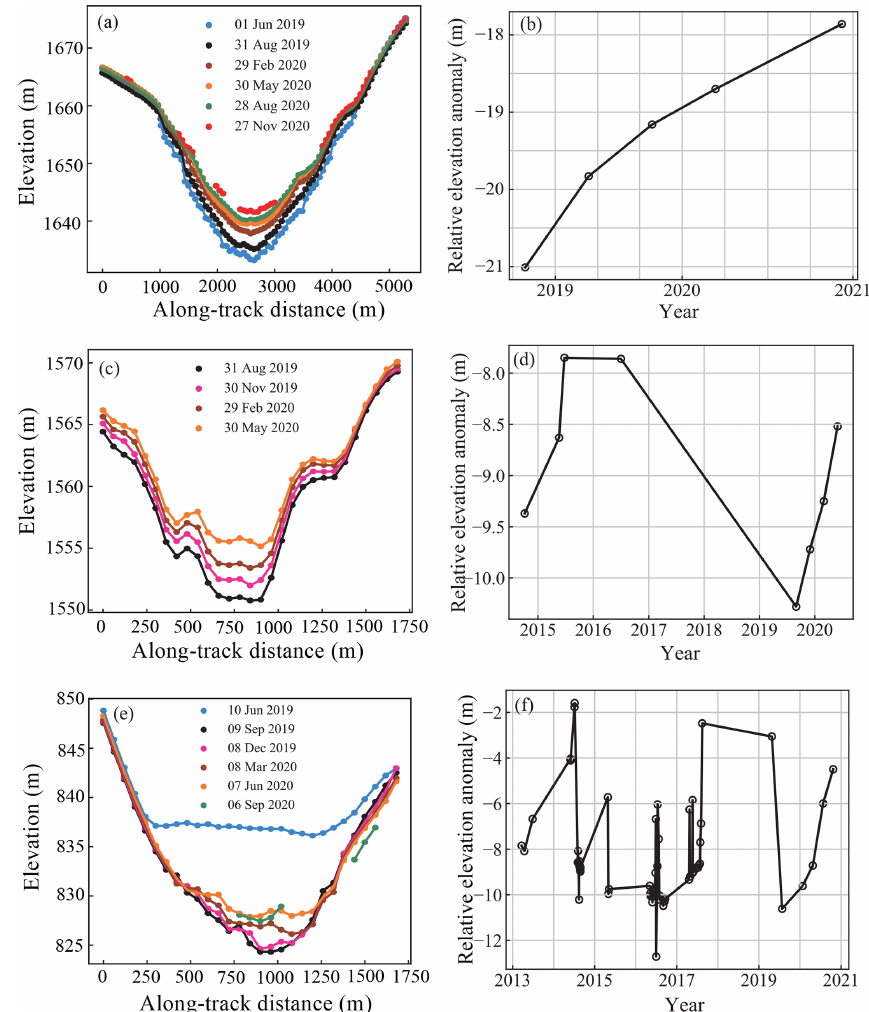
Figure 3. Examples of lake confidence-level classification. Panels (a, c, and e) show the elevation-anomaly profiles across the subglacial lake derived from ICESat-2, and the right column shows the time series elevation anomaly based on ArcticDEM and ICESat-2 tracks. The first row (Lake INUPPAAT_QUUAT02) is the high-confidence level, which exhibits gradual ice-surface elevation change and an elevation- change pattern typical of subglacial lakes. The second row (Lake KANGIATA_NUNAATA_SERMIA01) is a medium-confidence level lake, which shows consistent elevation change but with a less clear elevation-change pattern. The third row is a low-confidence level lake, which contains a clear flat spot and a seasonal elevation-change signal more typical of surface lakes and is therefore discounted from the inventory. More profiles can be found from Figs. S4 to